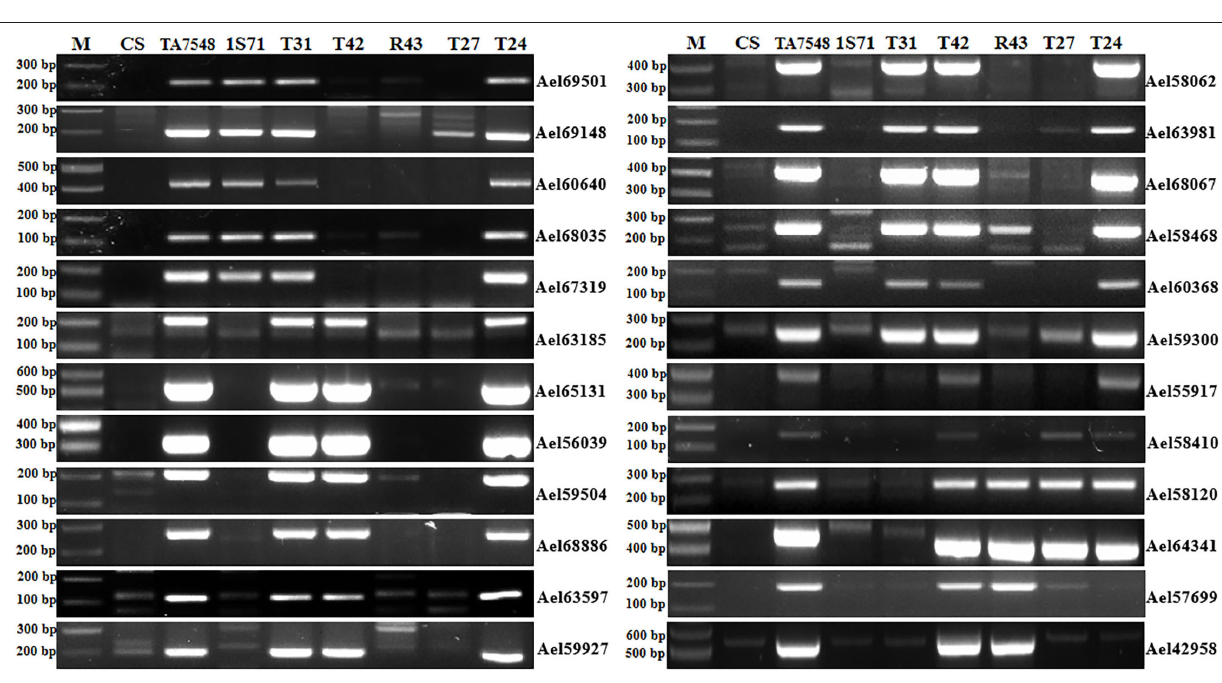
longissima chromatin, and FISH also failed to detect a difference from CS. This confirmed that any 6S l #3 segments in these lines should be small and beyond the resolving power of these